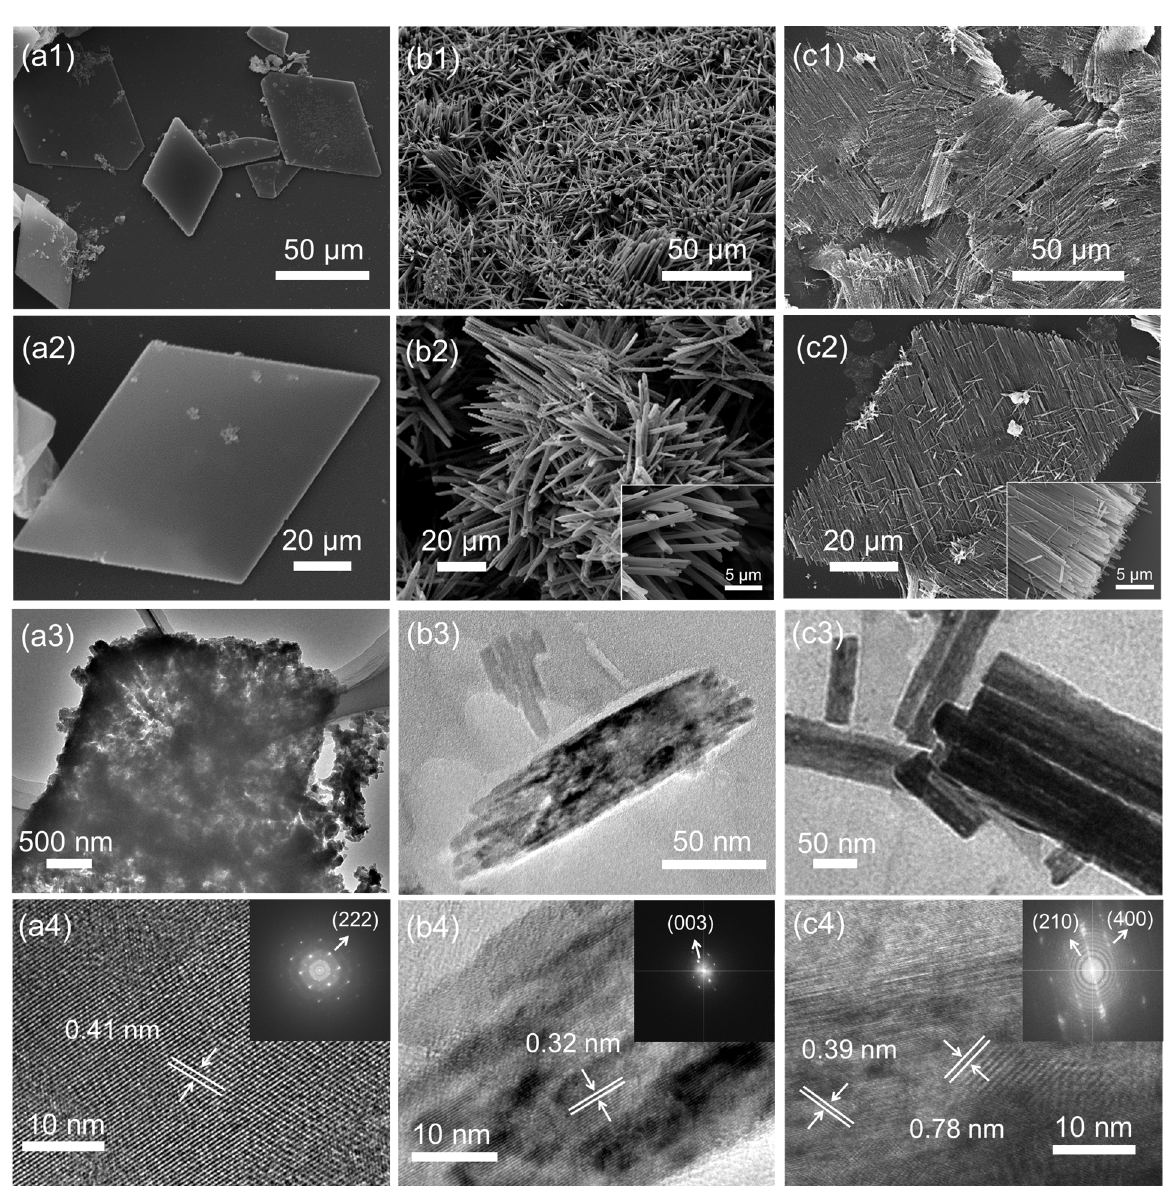
Figure 2. SEM, TEM, and HRTEM images of C 60 MSs ( a1 – a4 ), C 60 NRs ( b1 – b4 ), and C 60 -RNRAs ( c1 – c4 ). Insets of ( b2 ) and ( c2 ) are magnified SEM images. Insets of ( a4 , b4 , c4 ) are the corresponding electron diffraction patterns (The arrows point to the corresponding planes).